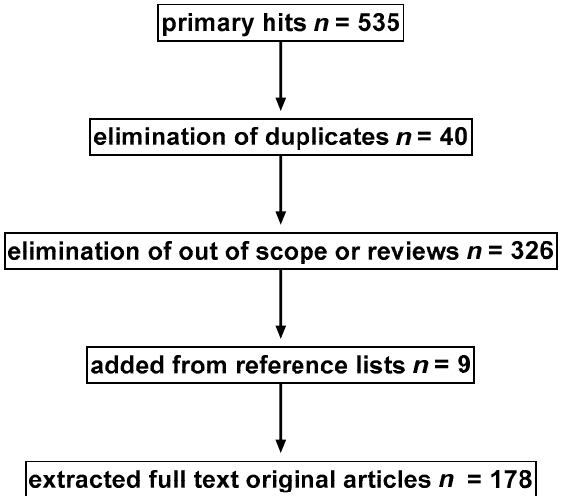
Figure 1. PRISMA flow chart of the handling of search results.